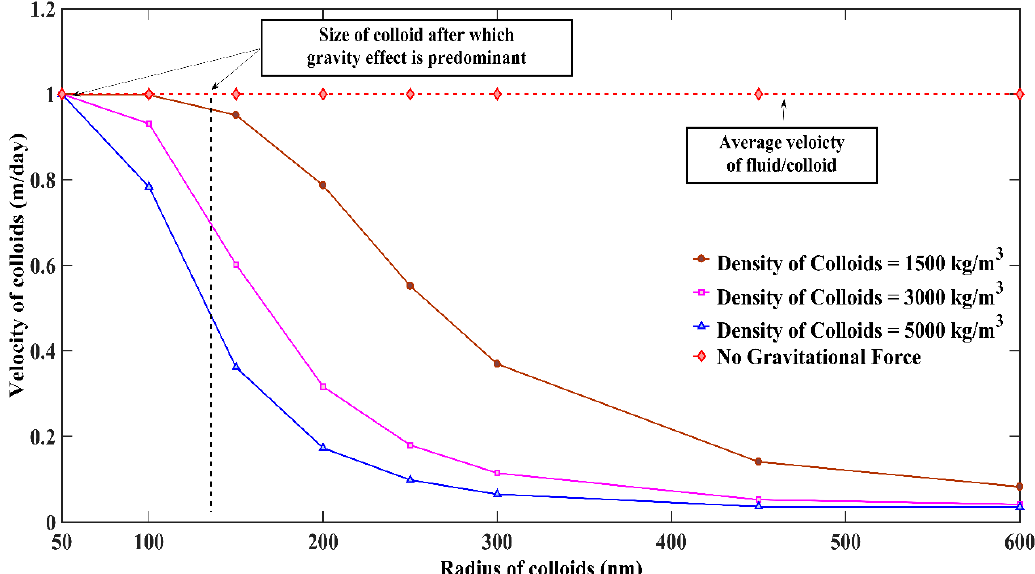
Figure 4. Influence of gravitational force on the colloidal velocity for different colloidal size (50 – 600 nm).